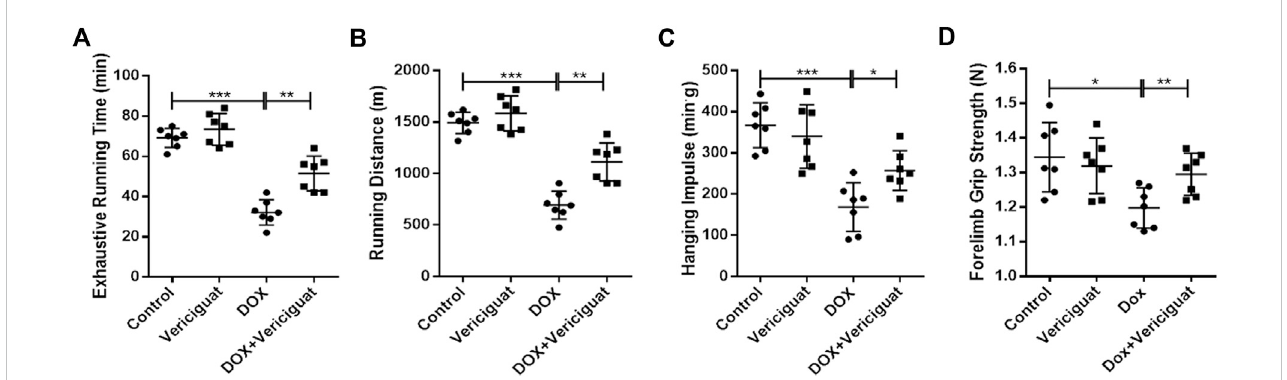
FIGURE 6 Veirciguat improved the decrease of exercise ability by DOX in mice. (A) Exhaustive running time (min). (B) Running distance (m) (C) Hanging impulse (min . g). (D) Forelimb grip strength (N). n = 7; *p < 0.05, **p < 0.01, ***p <